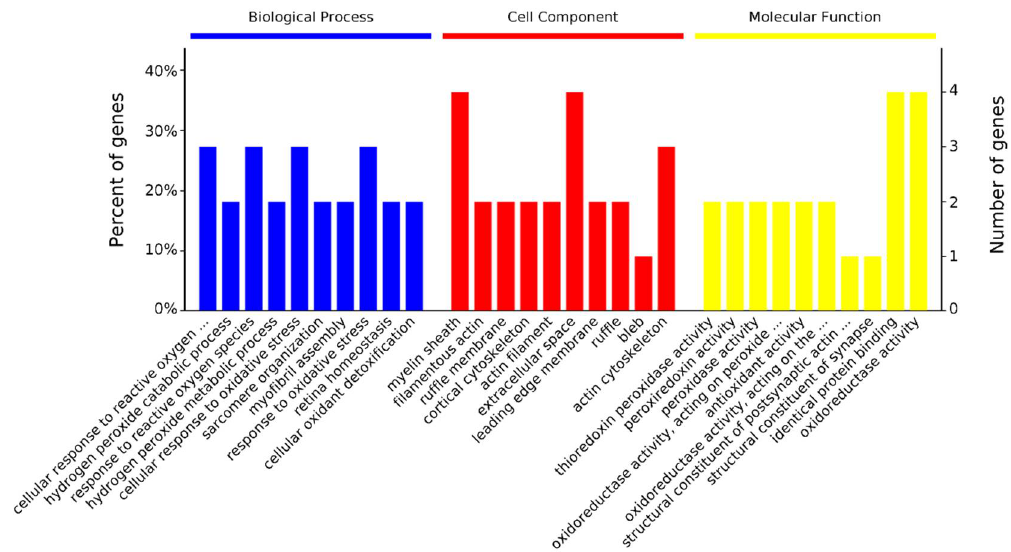
Figure 3. GO annotation of 13 differentially abundant proteins in three categories: biological process, cellular component, and molecular function at 14 vs. 28 day. Only the terms with p -values less than 0.05 are listed.